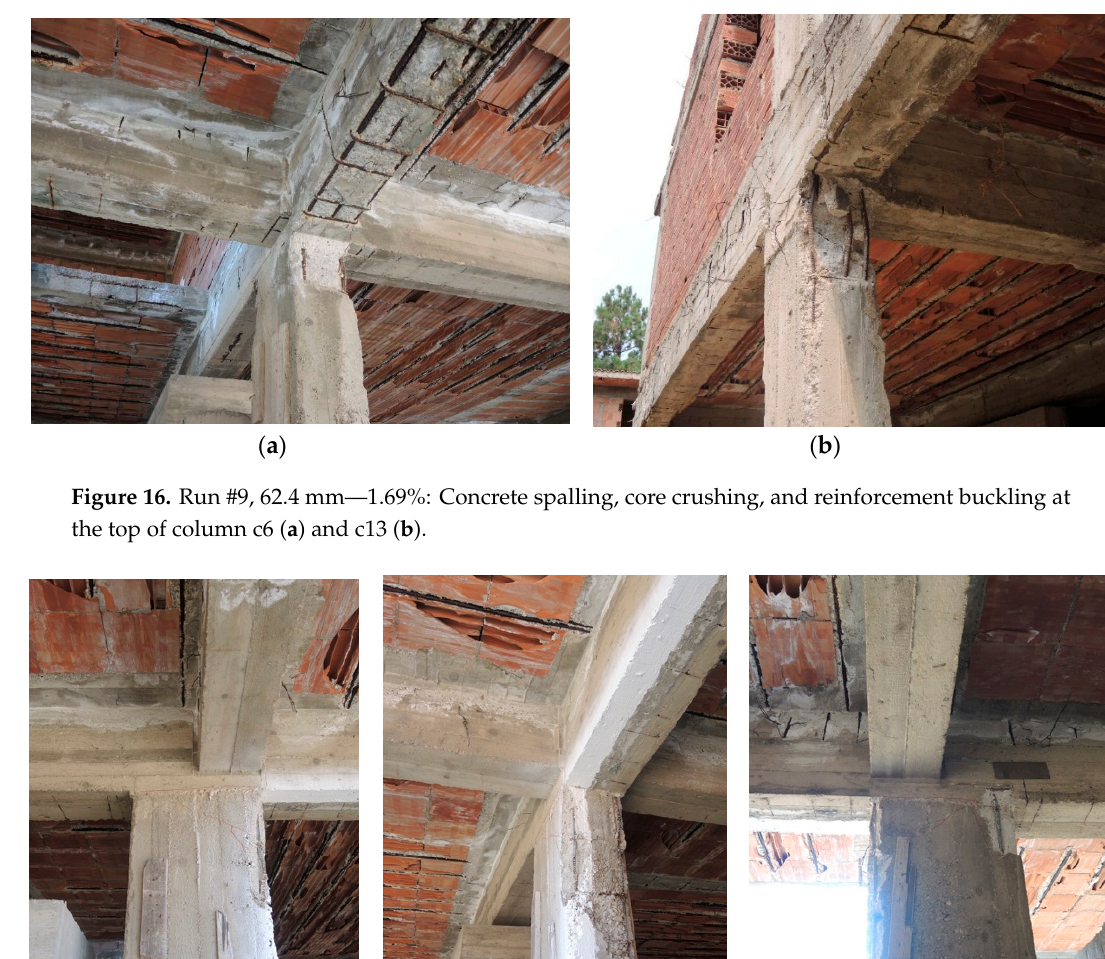
Figure 15. Run #9, 62.4 mm—1.69%: Infills parallel to the test direction fully collapsed.